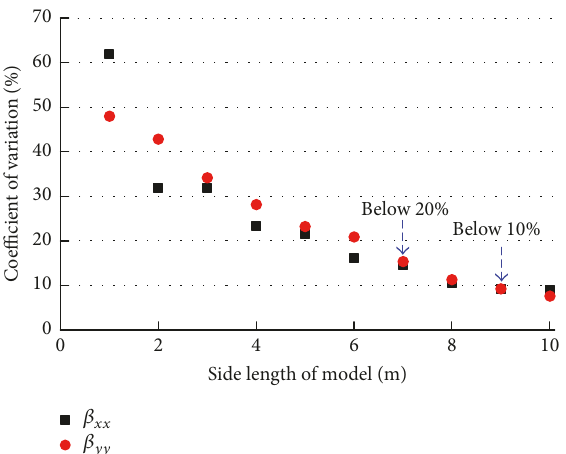
Figure 26: The values of coefficients of variation of 𝛽 𝑥𝑥 and 𝛽 𝑦𝑦 with increasing side lengths in the non-Darcy flow.